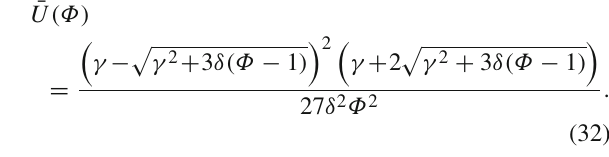
R ) is of the form f (